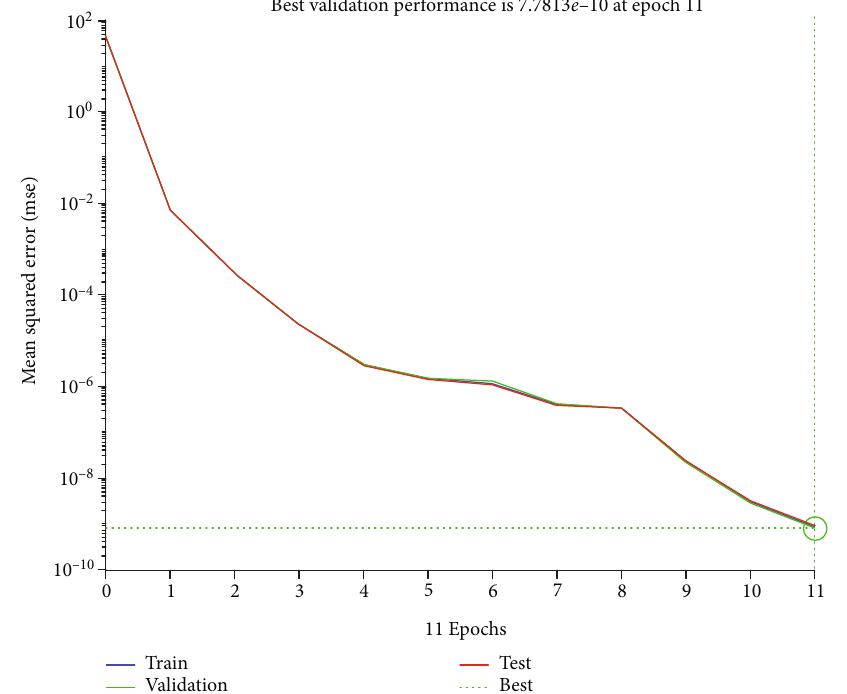
Figure 25: DNN-current regulator showing best validation performance.